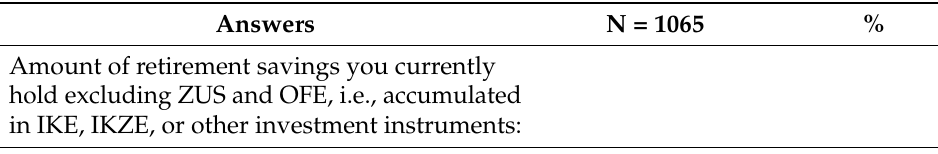
Table 3. The respondents’ tendency to save for the retirement period. Answers N = 1065